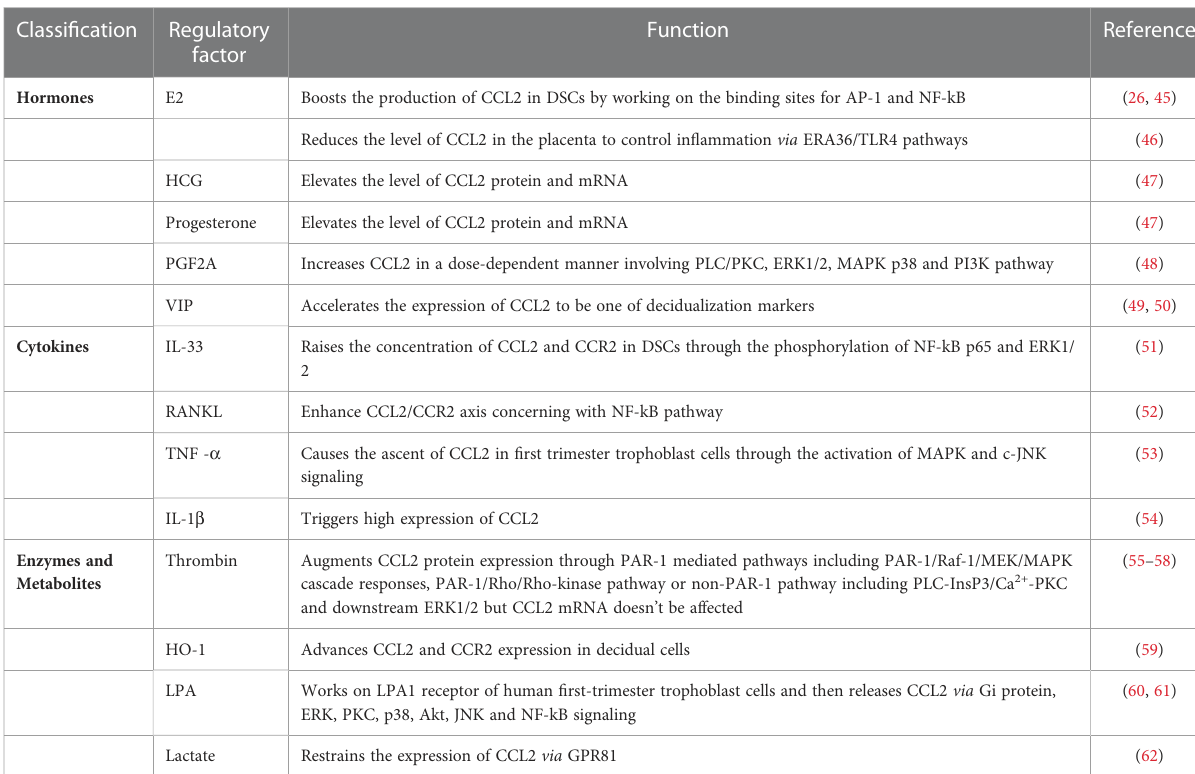
TABLE 2 Regulation of CCL2 expression at the maternal-fetal